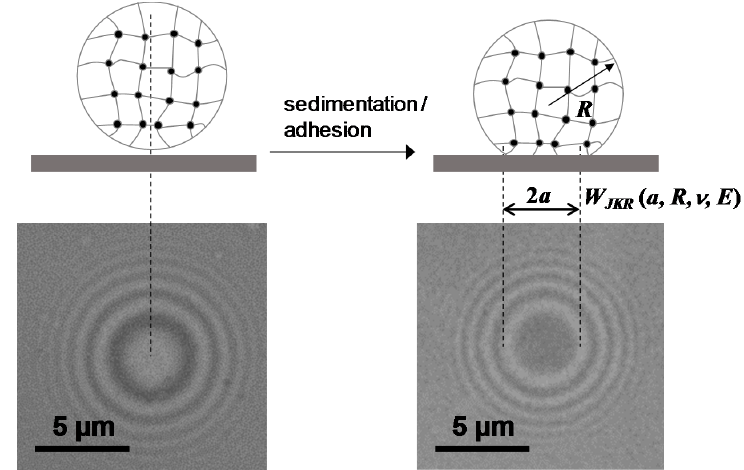
Figure 1. Principle of the Johnson-Kendall-Roberts (JKR) adhesion measurements with colloidal probes and typical reflection interference contrast microscopy (RICM) images ( bottom ) right before and after SCP adhesion. The dark area in the middle signifies the soft colloidal probe (SCP) contact area with the solid support.